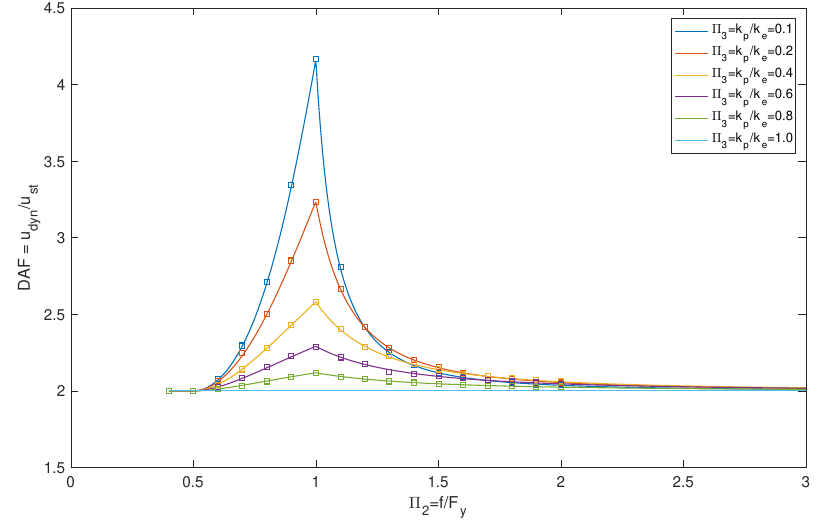
Figure 5. Dynamic amplification factor for various normalised loading and stiffness ratios. Squares represents the dynamic amplification factor (DAF) obtained through the numerical